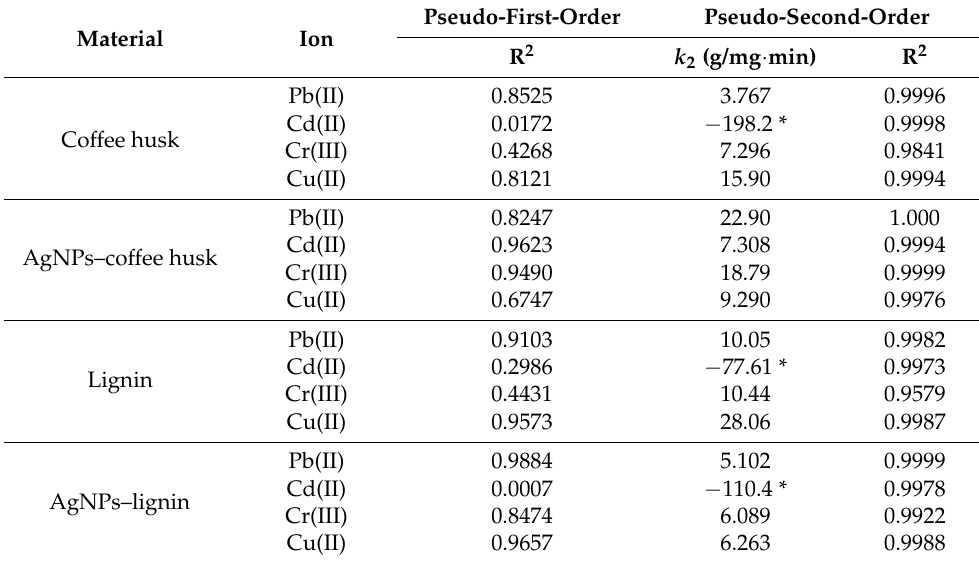
Table 2. Pseudo-first- and pseudo-second-order kinetic model values for sorption experiments of Pb(II), Cd(II), Cr(III), and Cu(II), all with an initial concentration of 0.18 mmol/L. The value k 2 is a velocity constant from the pseudo-second-order kinetic model.